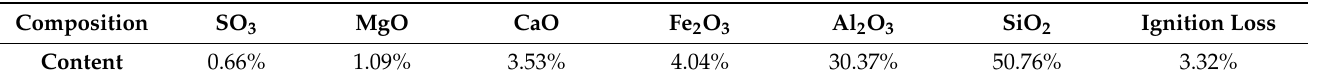
Table 2. Chemical composition of fly ash.